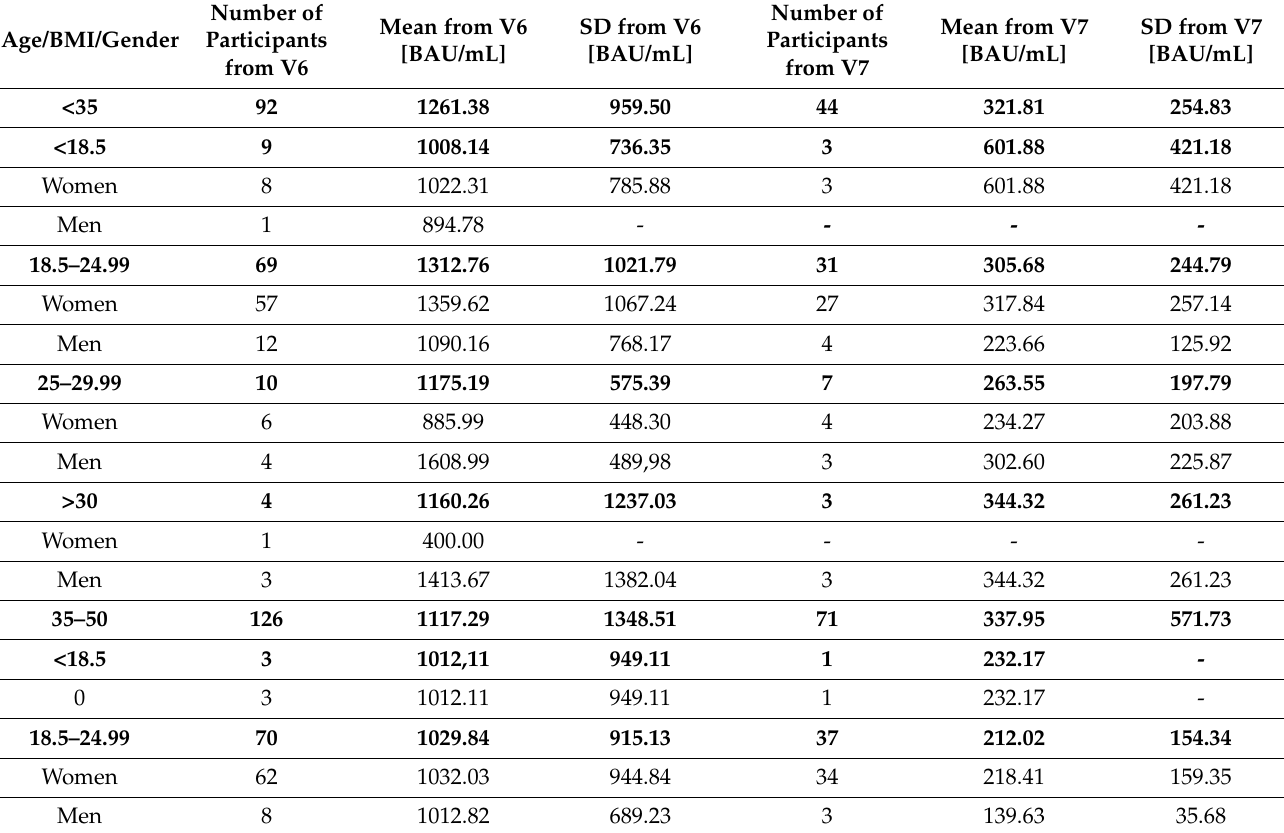
Table 5. Antibody concentrations in the age and gender structure in relation to